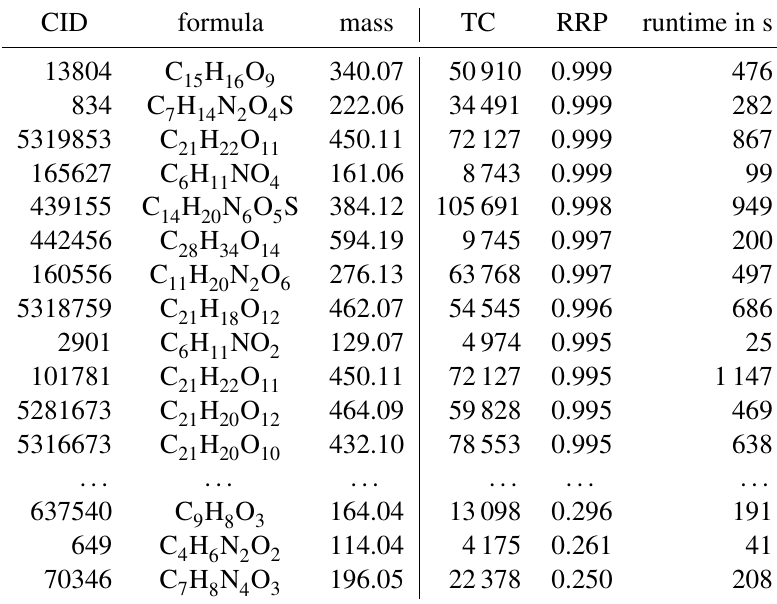
Table 1: The best and worst examples from one of the evaluation runs.